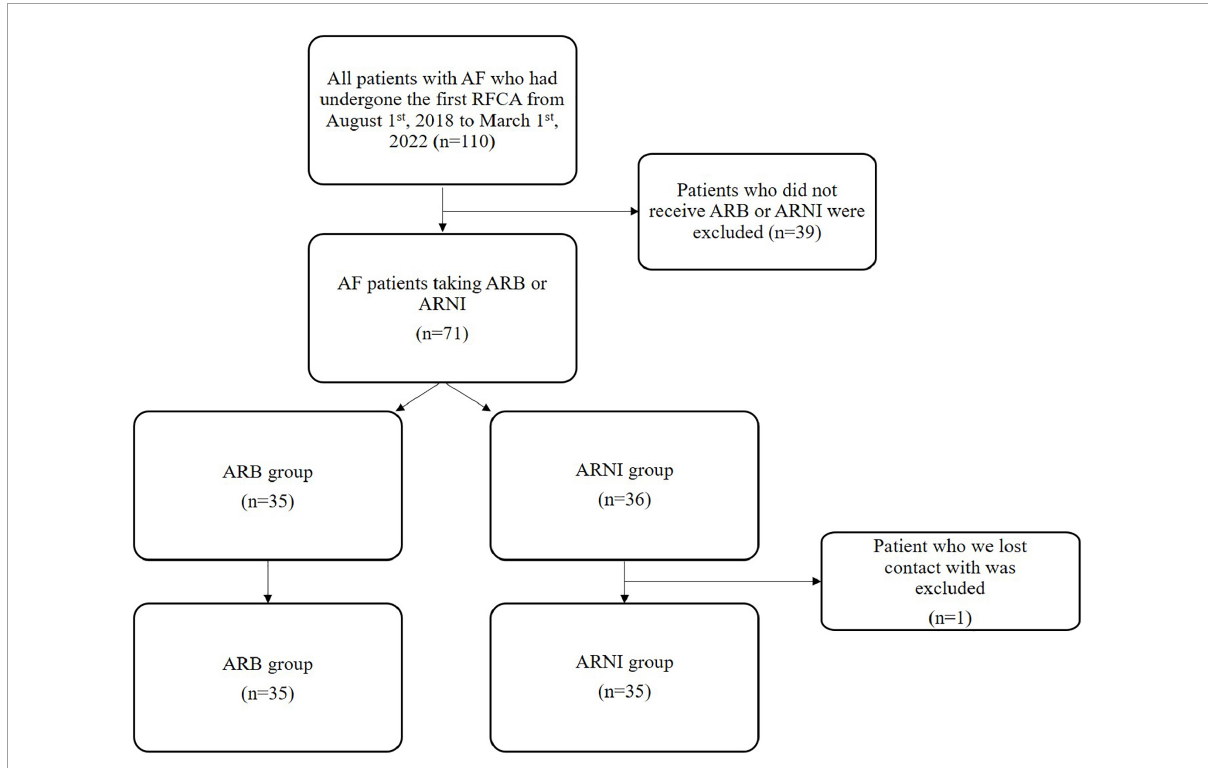
FIGURE1 Flowchart of clinical retrospective study. AF, atrial fibrillation; RFCA, radio frequency catheter